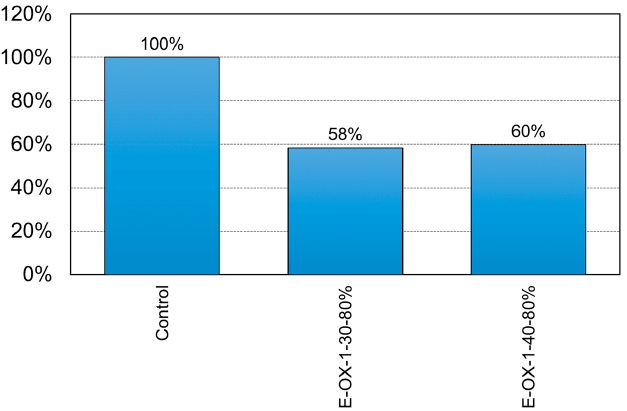
Figure 10. Ductility of NSM specimens (Concrete strength).